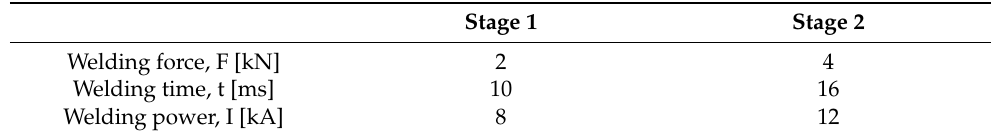
( c ) Figure 3. Schematic representation of joint formation using adhesive: ( a ) welding of insert element to aluminum, ( b ) application of adhesive on aluminum substrate, ( c ) welding of steel plate to insert– aluminum joint. The following types of adhesives were chosen for the experiments, and their proper- ties are described in more detail in Table 6.